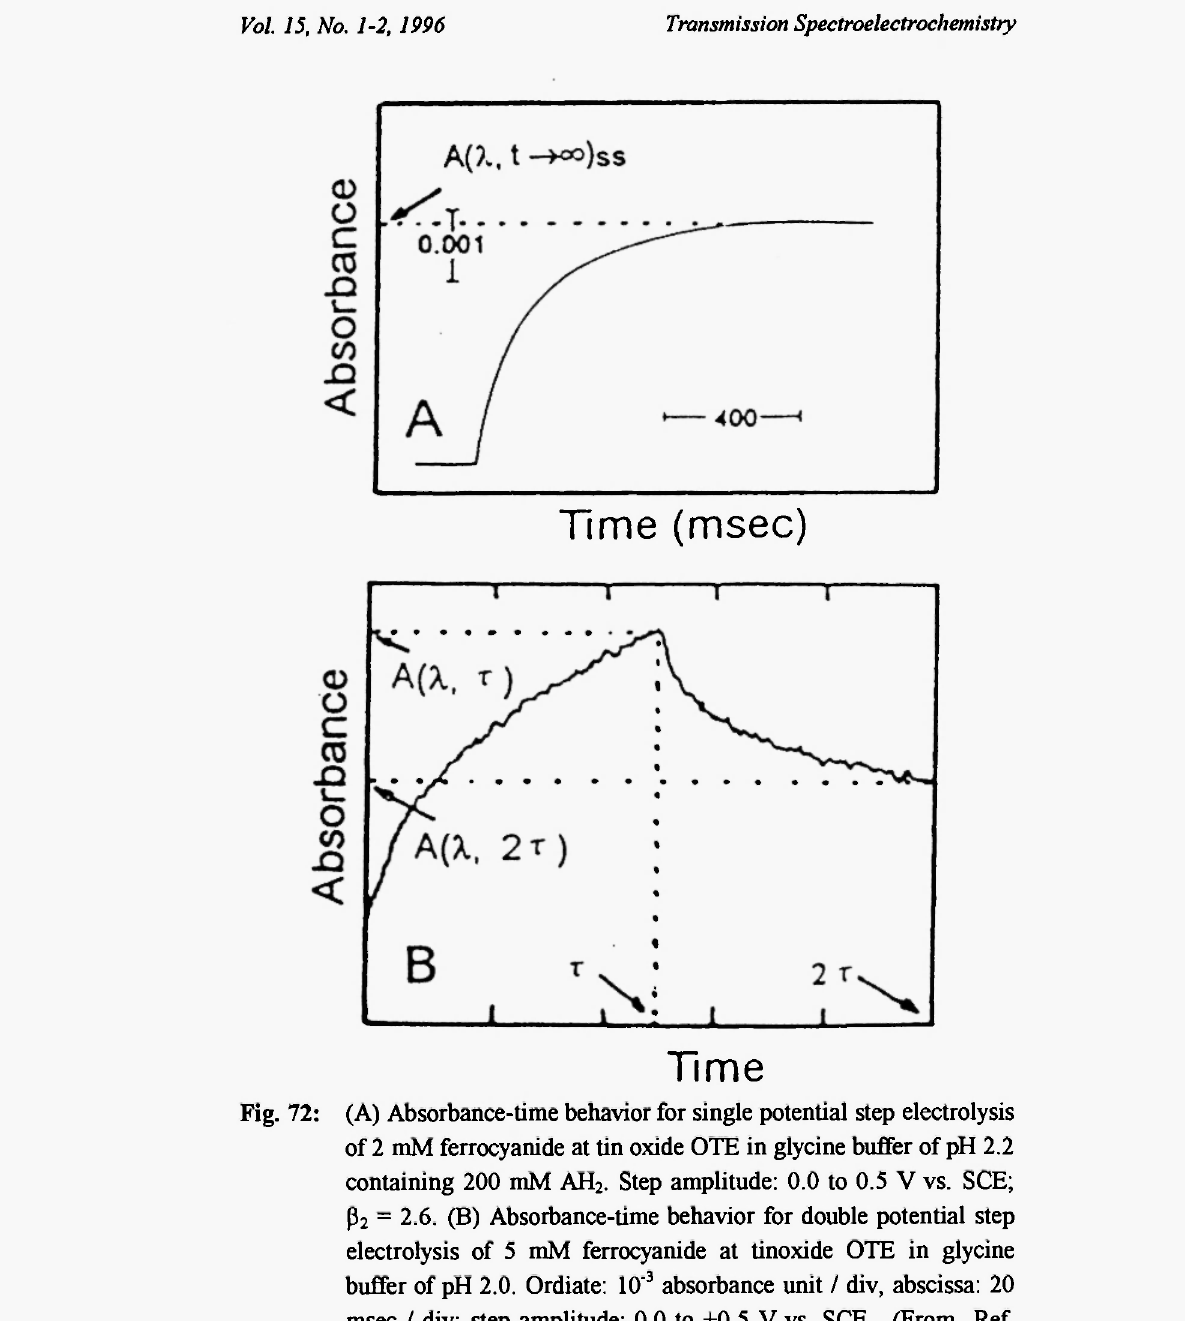
Fig. 72: (A) Absorbance-time behavior for single potential step electrolysis of 2 mM ferrocyanide at tin oxide OTE in glycine buffer of pH 2.2 containing 200 mM AH . Step amplitude: 0.0 to 0.5 V vs. SCE; 2 ß = 2.6. (Β) Absorbance-time behavior for double potential step 2 electrolysis of 5 mM ferrocyanide at tinoxide OTE in glycine buffer of pH 2.0. Ordiate: 10" 3 absorbance unit / div, abscissa: 20 msec / div; step amplitude: 0.0 to +0.5 V vs. SCE . (From Ref.